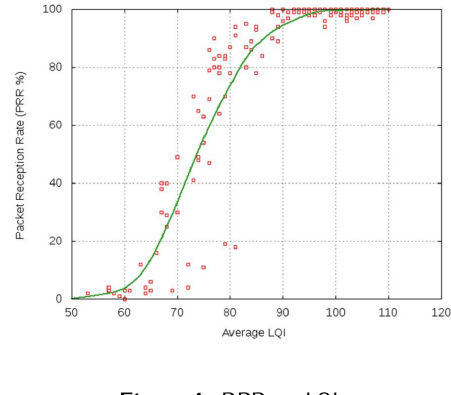
Figure 4. PRR vs.